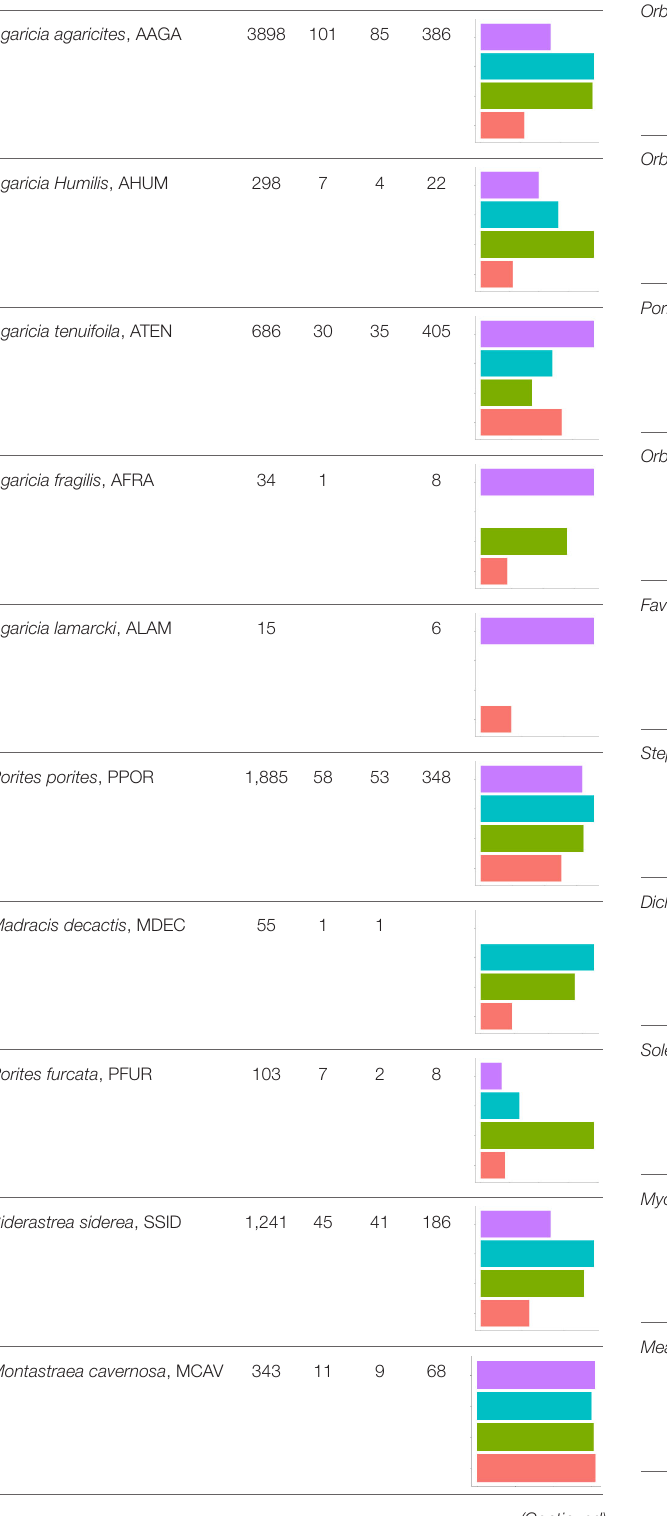
TABLE 4 | Colony abundance for each of the species recorded by the sampling designs. Spp VT